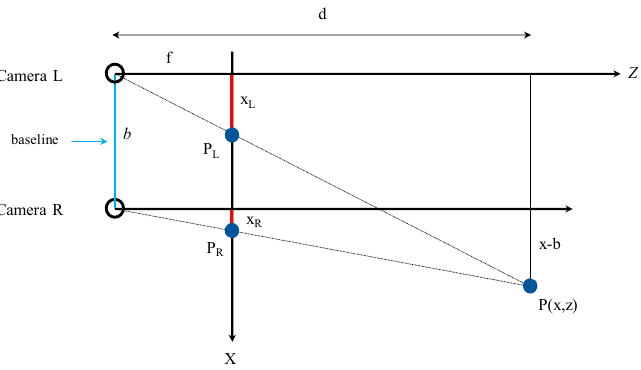
Figure 5. Binocular camera ranging geometric model. Where Camera L and Camera R are the optical centers of the left and right cameras, respectively, and the distance between them is called the baseline of the binocular camera, denoted by b . P L and P R are the imaging points of the spatial point P on the left and right cameras at the same time, respectively. x L and x R are the distances between the imaging points P L and P R and the optical axes of the left and right cameras, respectively. f is the focal length. d is the distance between the spatial point p and the baseline of the binocular camera.